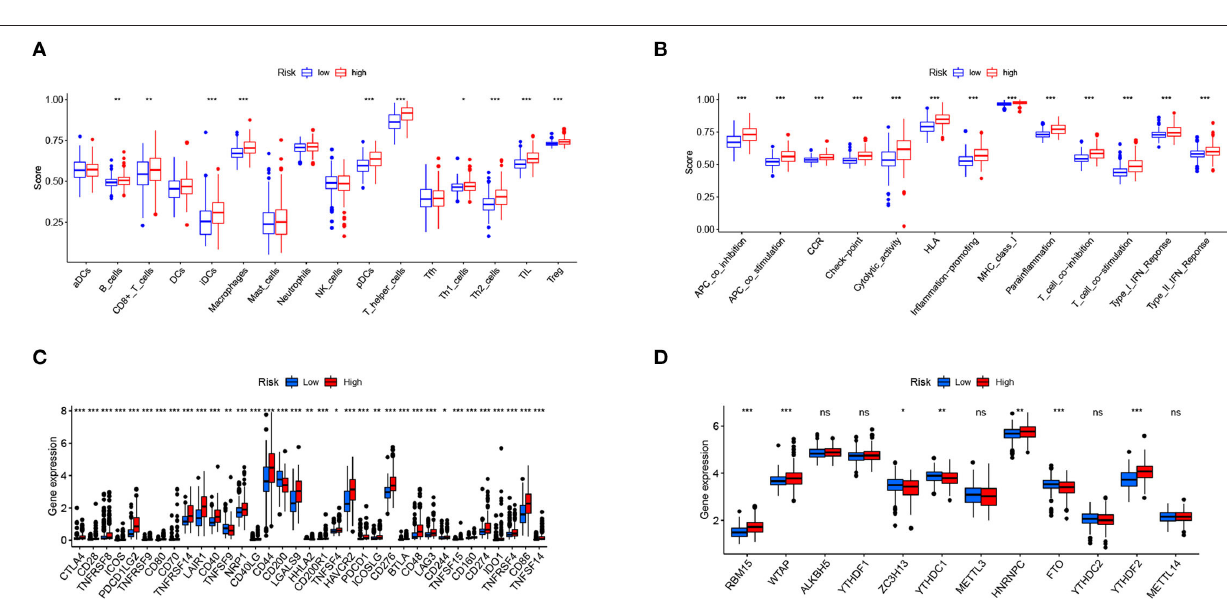
Frontiers in Neurology |